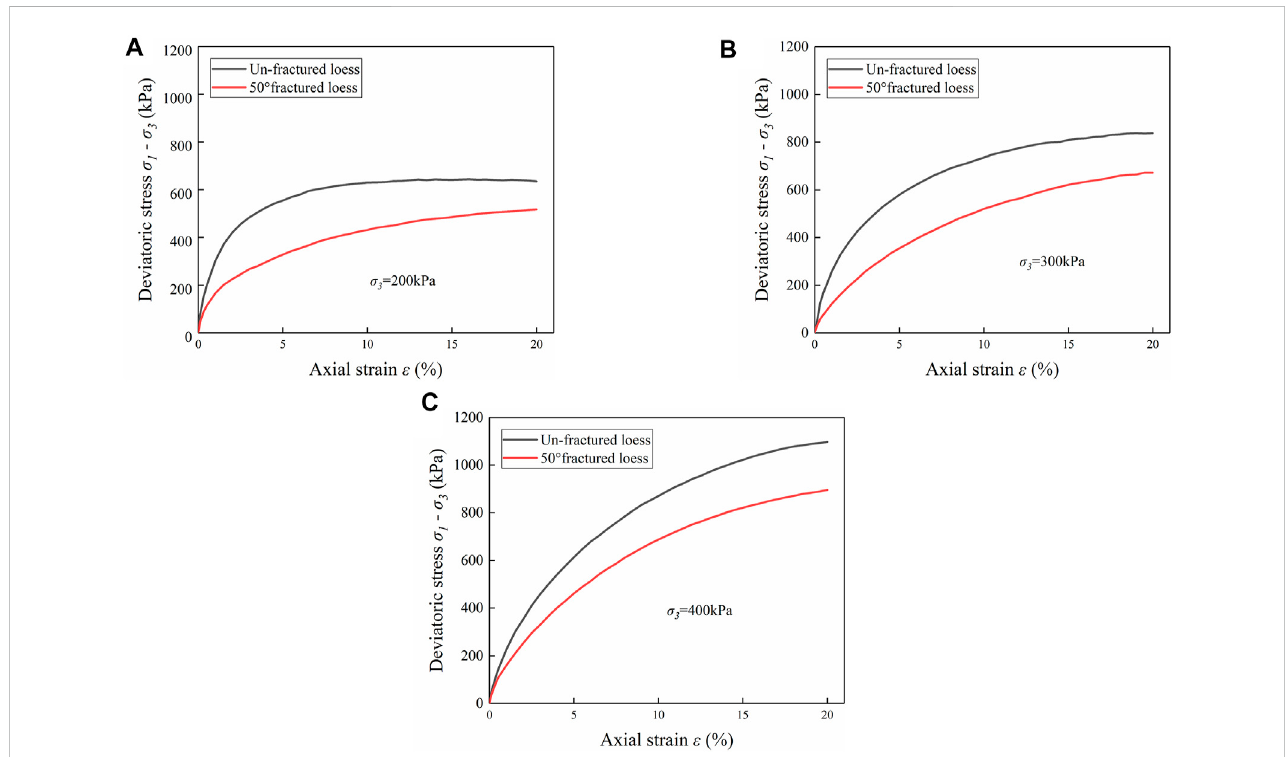
FIGURE 3 Deviator stress versus axial strain of without fractured loess and 50 ° fractured loess: (A) σ 3 =200 kPa; (B) σ 3 =300 kPa; (C) σ 3 =400 kPa σ 3 con fi ning pressure.